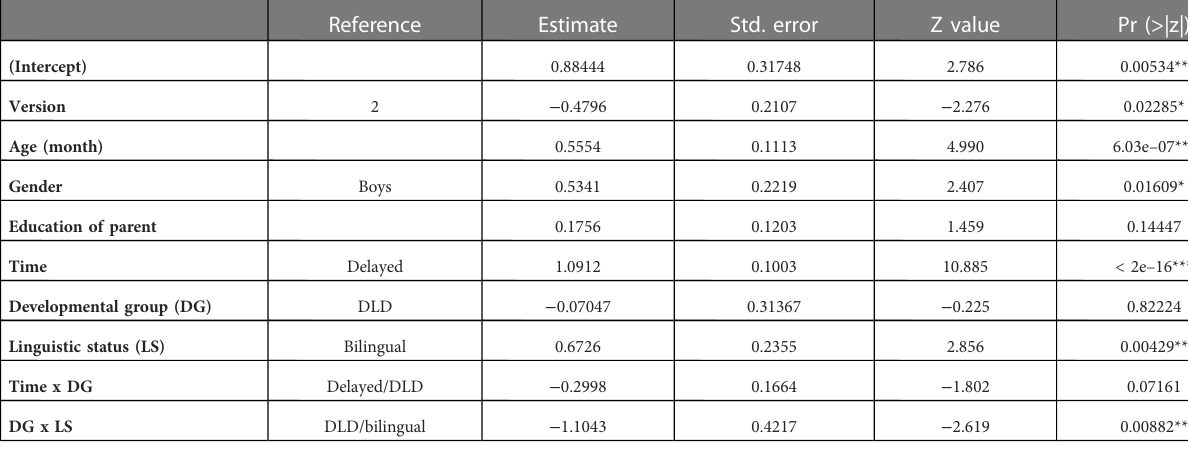
TABLE 9 Results on generalized linear mixed model for semantic prompts.